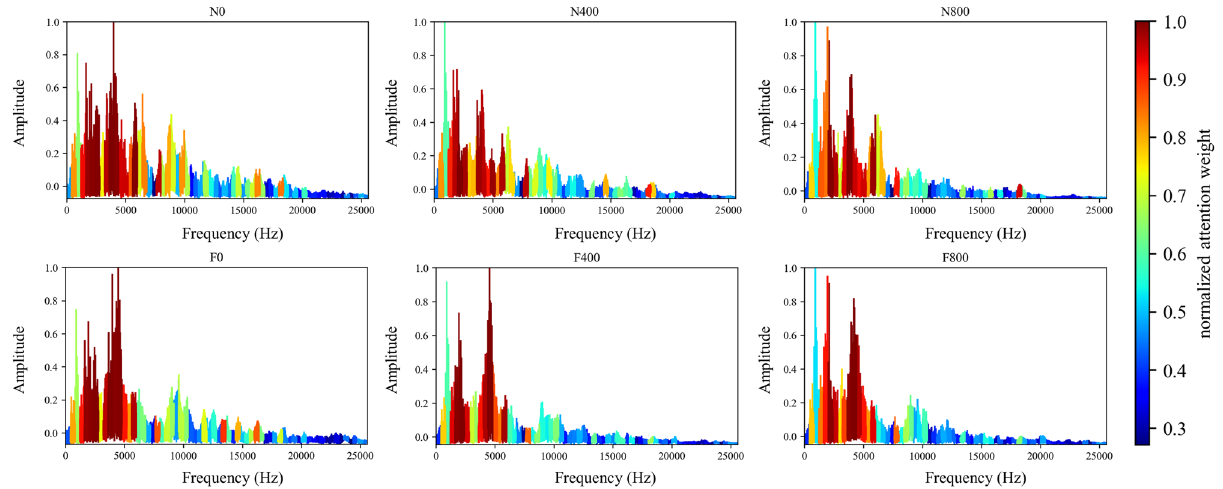
Figure 19. Visualization of attention weight in Global